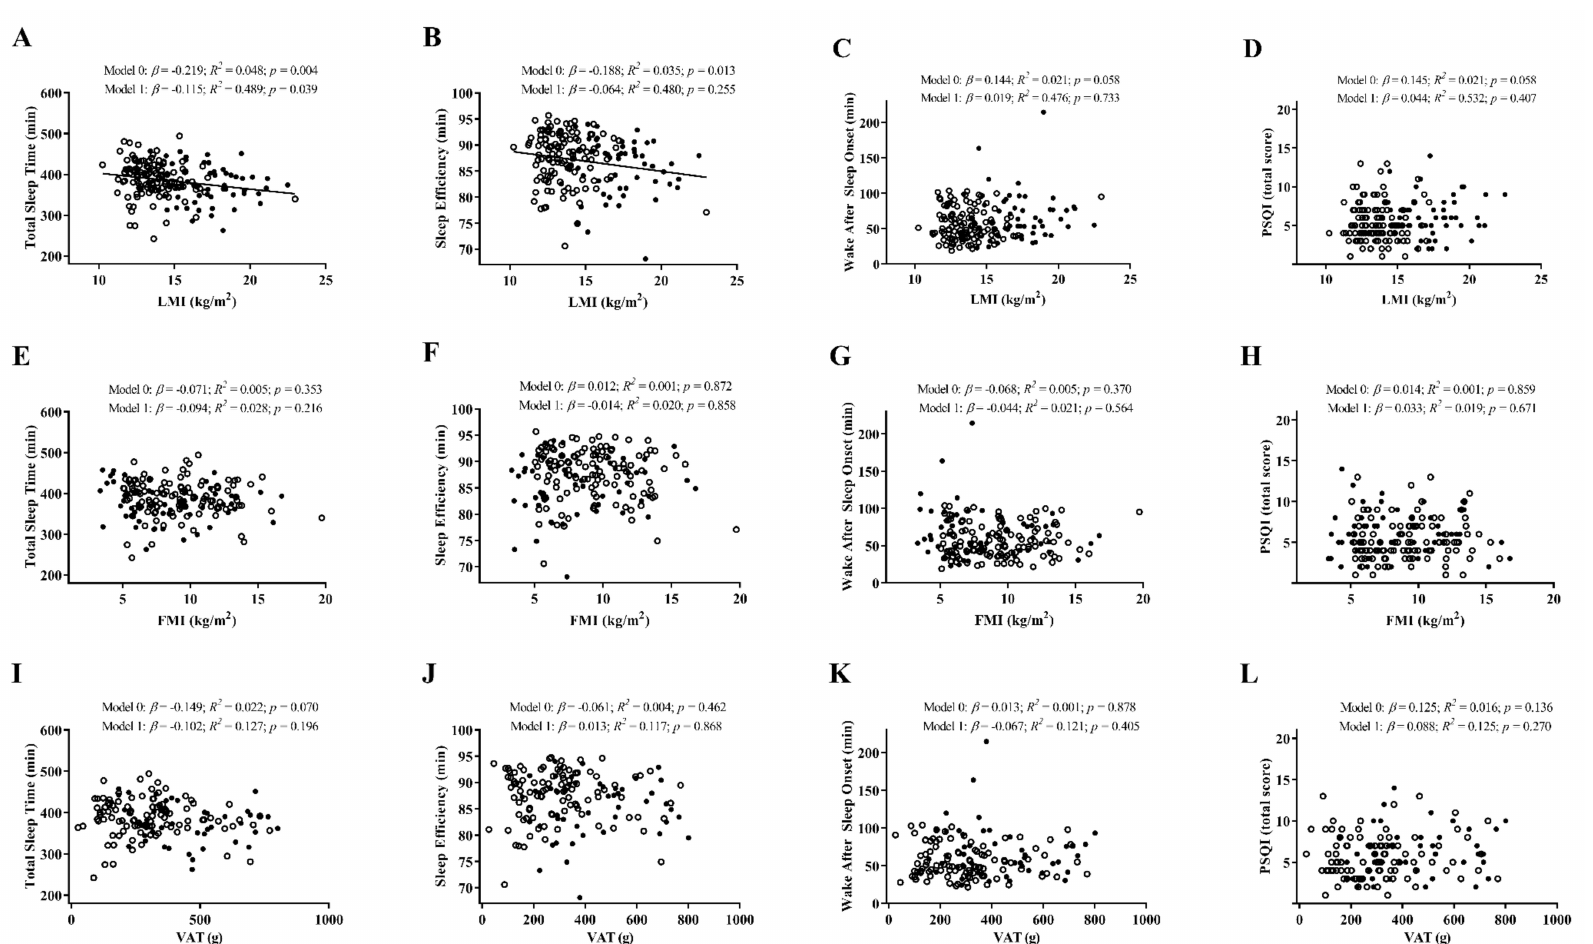
Figure 2. Linear regression graphs of lean mass index (LMI), fat mass index (FMI), and visceral adipose tissue (VAT) with total sleep time (Panels ( A , E , I )), sleep e ffi ciency (Panels ( B , F , J )), wake after sleep onset (Panels ( C , G , K )), and PSQI total score (Panels ( D , H , L )), before and after adjusting by sex (model 0 and model 1, respectively). β , standardized linear regression coe ffi cient; R 2 , coe ffi cient of determination; p , p -value. Closed and open circles represent men and women, respectively. Abbreviations: LMI, lean mass index; FMI, fat mass index; VAT, visceral adipose tissue mass; PSQI, Pittsburgh sleep quality